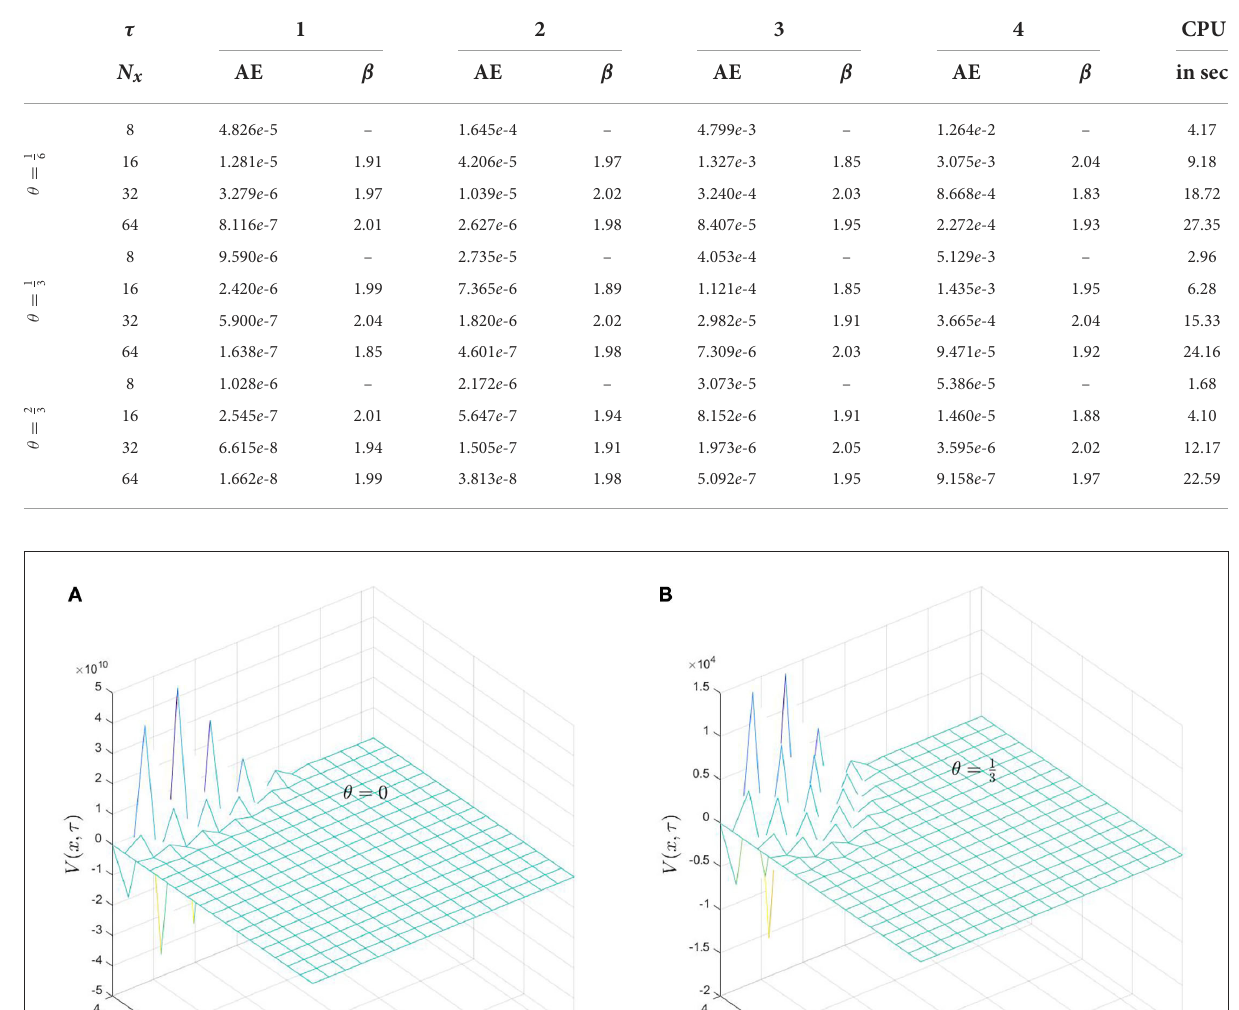
TABLE 4 Absolute errors, their convergence rates, and CPU time for several values of N x , when N τ = 1024 for the problem given in Example 1.